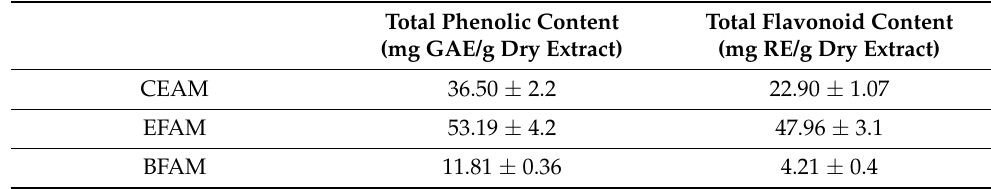
Data are expressed as mean ± SD, ( n =